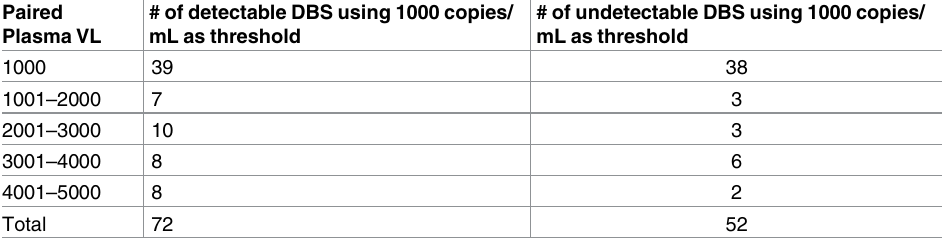
Table 4. Plasma viral load ranges of the 72 DBS samples with plasma VL ranging from 1000 to 5000 copies/mL. Paired Plasma